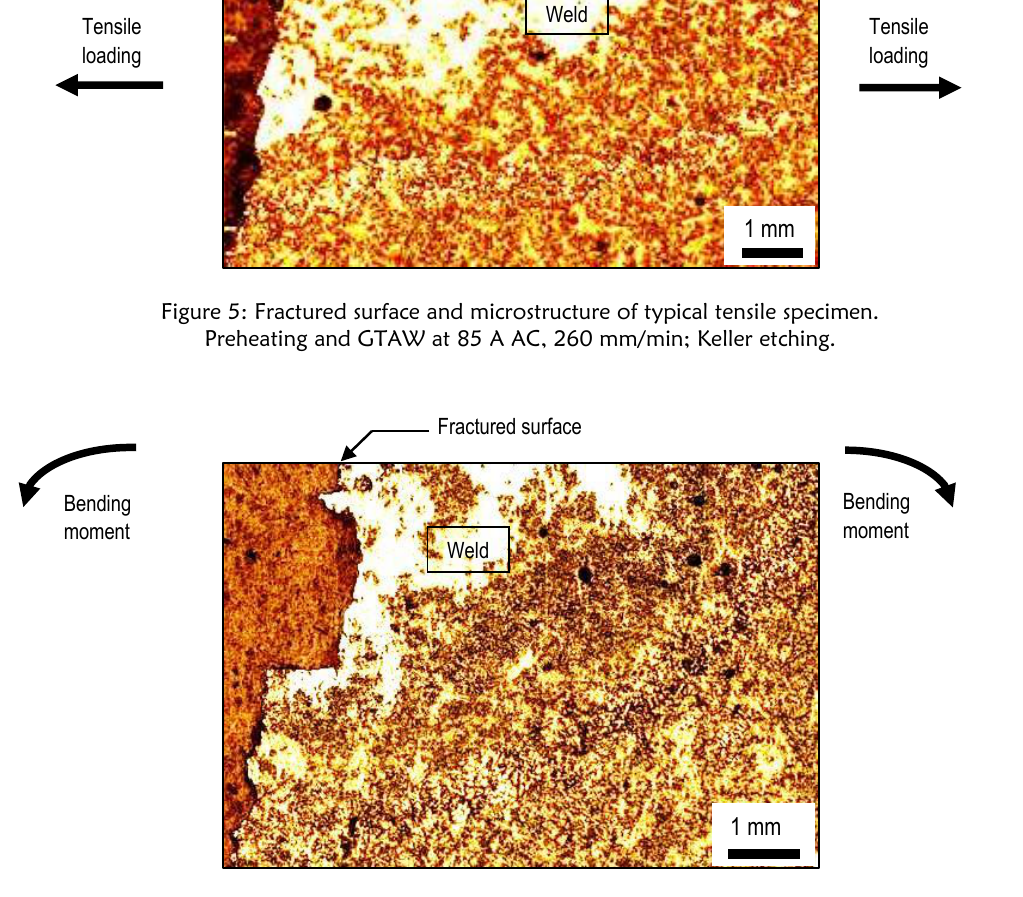
Figure 6: Fractured surface and microstructure of typical four-point bending specimen. Preheating and GTAW at 85 A AC, 260 mm/min; Keller